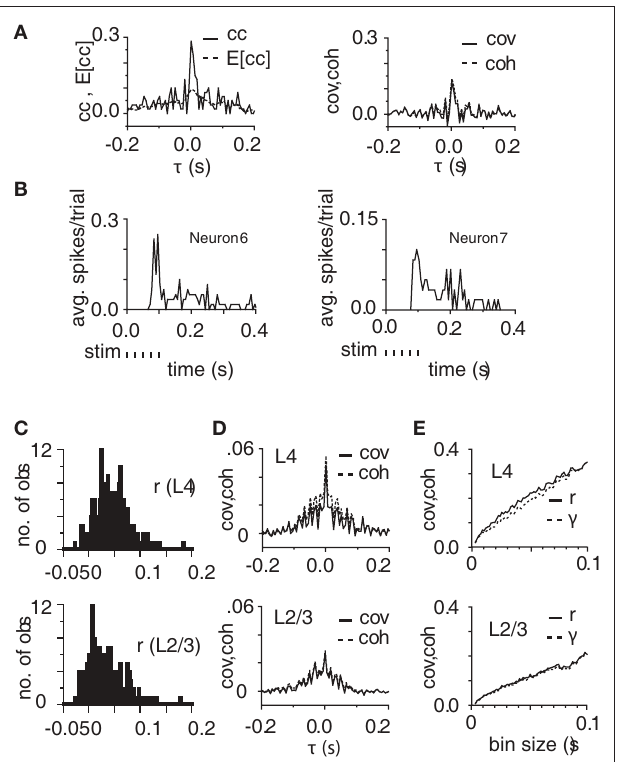
Figure 2 | Signal propagation and propagation of correlations from L4 to L2/3. (A) Graphs show the cross-correlation, (cc( τ )) and expected cross-correlation, (E[cc( τ )]) functions (left) and the covariance, (cov( τ )) and coherence, (coh( τ )) functions (right) for an example pair of neurons [cov( τ ) and coh( τ ) denote normalized cross-covariance and complex coherence, respectively]. In the illustrated example responses were binned with a bin size of 6.14 ms. (B) Peristimulus time histograms of the two neurons. (C) Histogram of cross-correlation coefficient ( r ) for all 190 neuron pairs in L4 (top) and all 190 pairs in L2/3 (bottom). (D) Average covariance and coherence for all pairs of neurons in L4 (top graph) and all pairs in L2/3 (bottom graph, bin size = 6.14 ms). (e) Cross-correlation coefficient ( r ) and complex coherence ( γ ) of L4 (top) and L2/3 (bottom) neurons for bin sizes from 1.536 to 99.83 ms in steps of